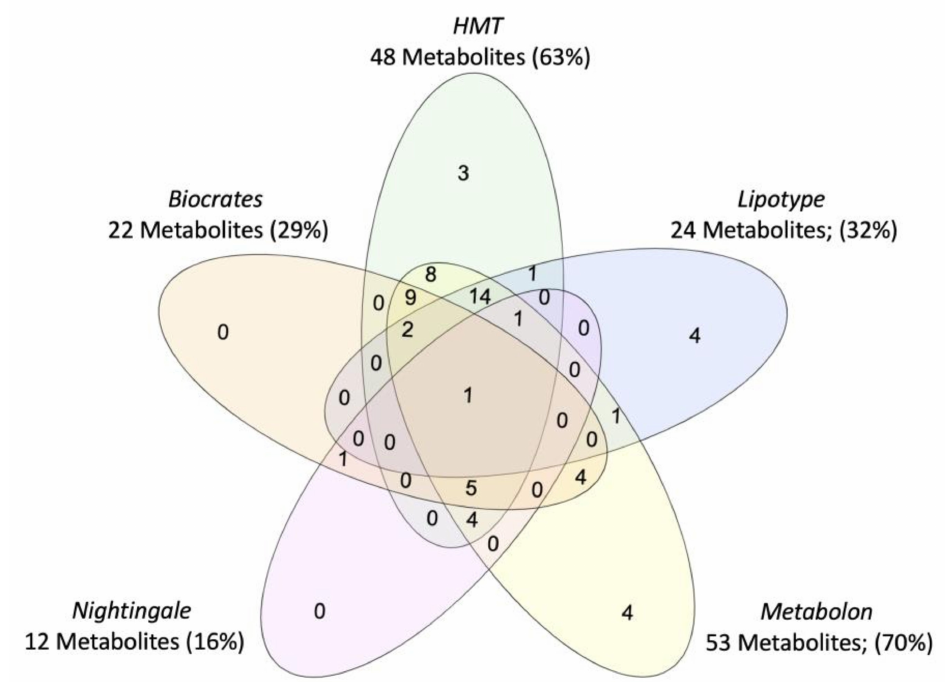
Figure 2. Venn diagram of coverage for PTSD-associated metabolites, for the five commercial metabolomics vendors assessed in the systematic platform comparison. Metabolites were identified through systematic review of case vs. control studies in PTSD.